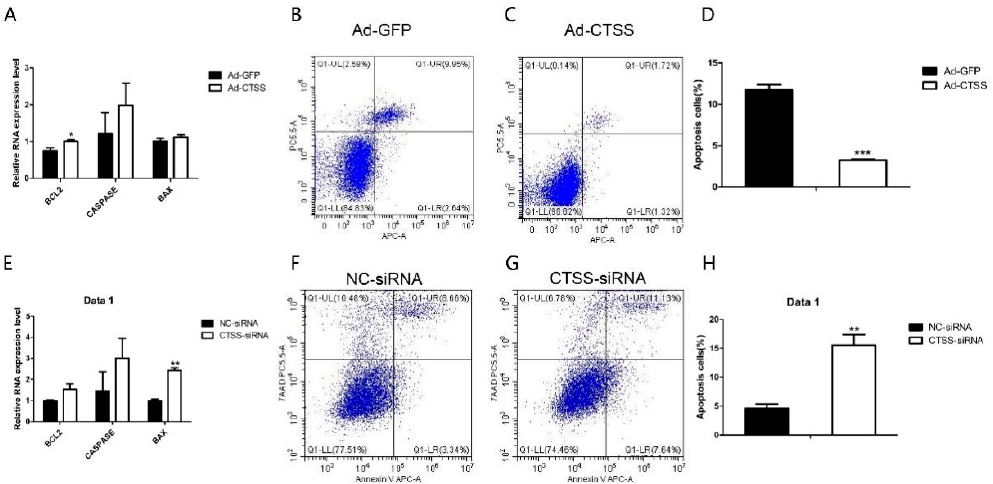
Figure 5. Effect of CTSS overexpression and interference on cell apoptosis in rabbit GCS: Relative mRNA expression changes of marker genes related to cell apoptosis after CTSS overexpression ( A ) and knockdown ( E ). Cell apoptosis rate was measured by using flow cytometry after CTSS overexpression ( B – D ) and knockdown ( F – H ). * p < 0.05; ** p < 0.01; *** p < 0.001